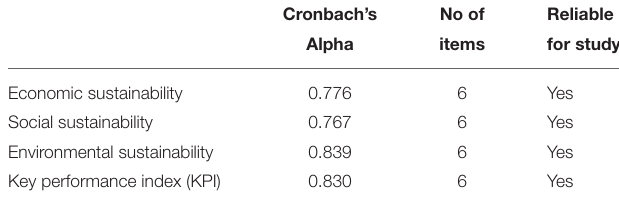
TABLE 5 | Reliability